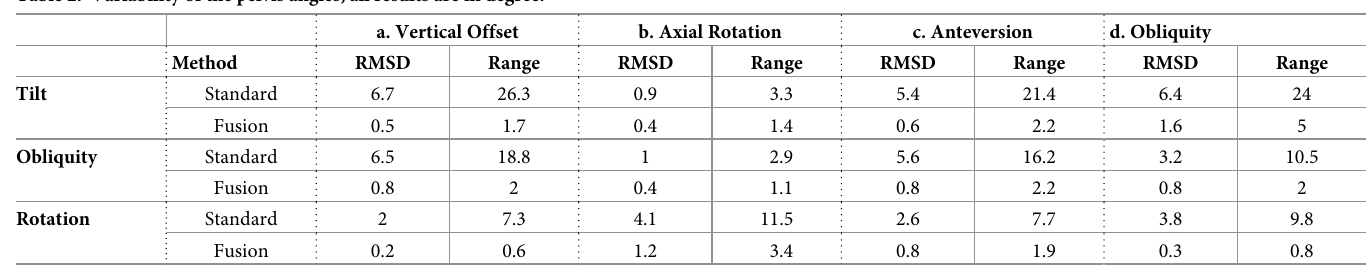
Table 2. Variability of the pelvis angles, all results are in degree.